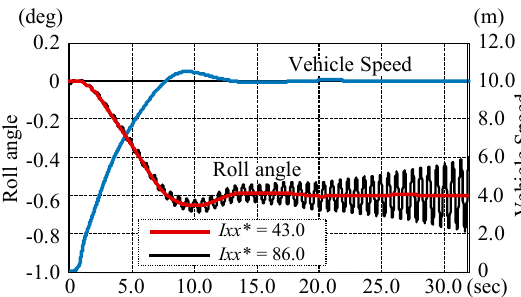
Figure 6. Unstable roll vibration with high Ixx *.